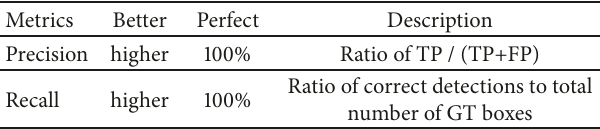
Table 2: Evaluation metrics for vehicle detection, TP is the total number of true positives, FP is the total number of false positives, and GT indicates ground